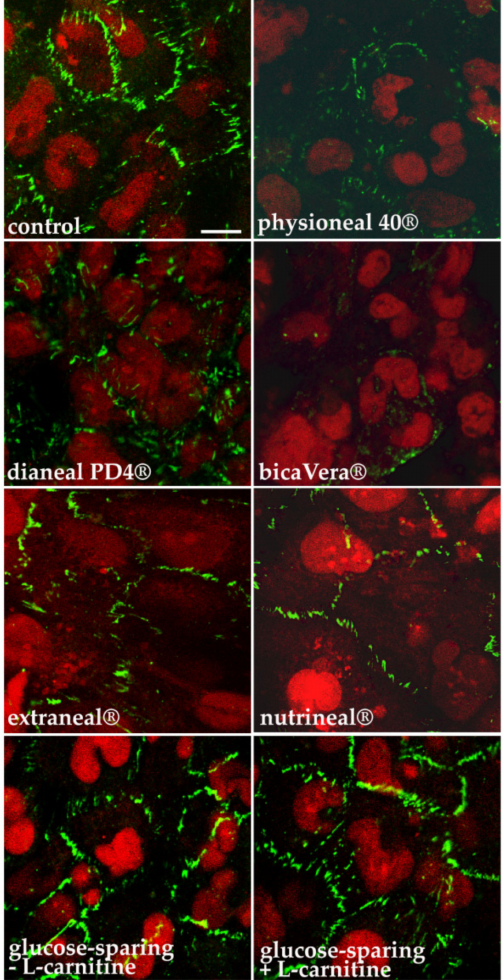
Figure 2. Immunofluorescence analysis of tight junction marker Zo-1 in HMC, grown on permeable supports and exposed for 8 h to different PD solutions at the apical side. HMC monolayers grown on permeable supports were incubated for 8 h at the apical side with high osmolarity glucose-based PD solutions (Physioneal 40 ® , Dianeal PD4 ® and BicaVera ® ), glucose-free Extraneal ® /Nutrineal ® and high osmolarity glucose-sparing PD solutions ( ± L -carnitine). Cells were immunostained with anti Zo-1 antibodies (green) and scanned by laser confocal microscopy. Nuclei were stained with propidium iodide (red). Scale bars = 10 µ